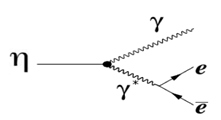
Figure 3. η transition form factor comparison between this work, CB / TABS result, pure QED and Vector Meson Dominance theorical model. Black points correspond to experimental data. They are fitted by the following function: 1 where 1 − β η m 2 ee m ee is the e + e − invariant mass and β η is the η transition form factor slope